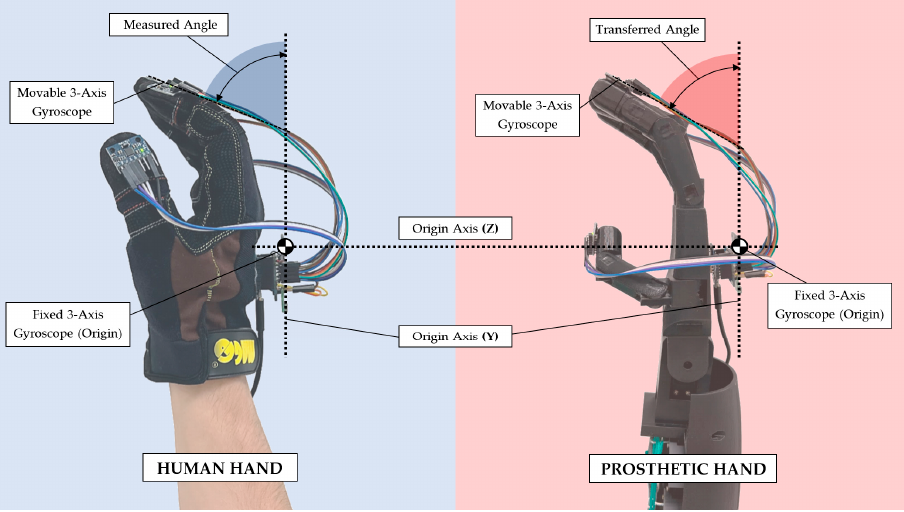
Figure 9. The principle of measuring and transferring the angle (from the hand/glove to the prosthesis).